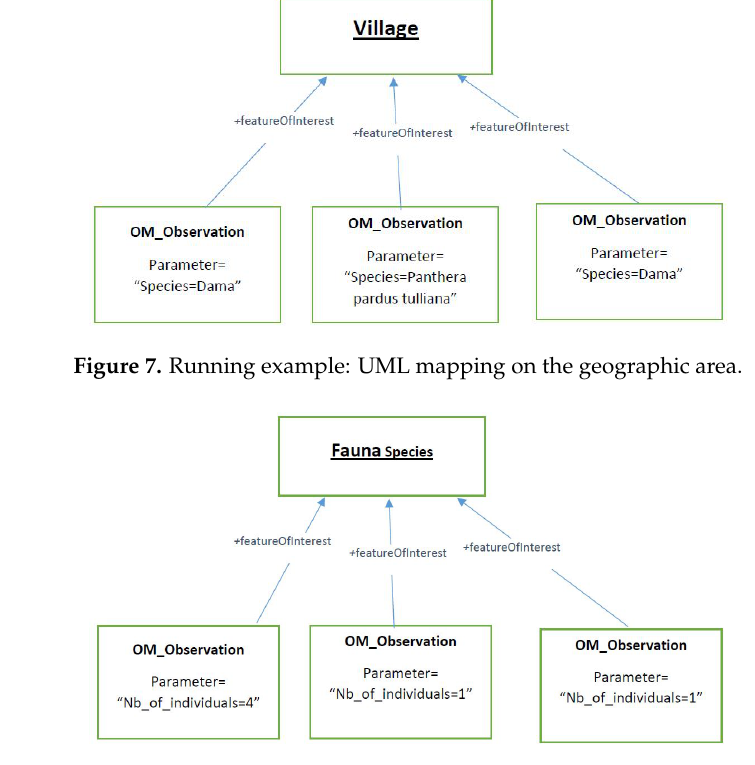
Figure 8. Running example: UML mapping on the